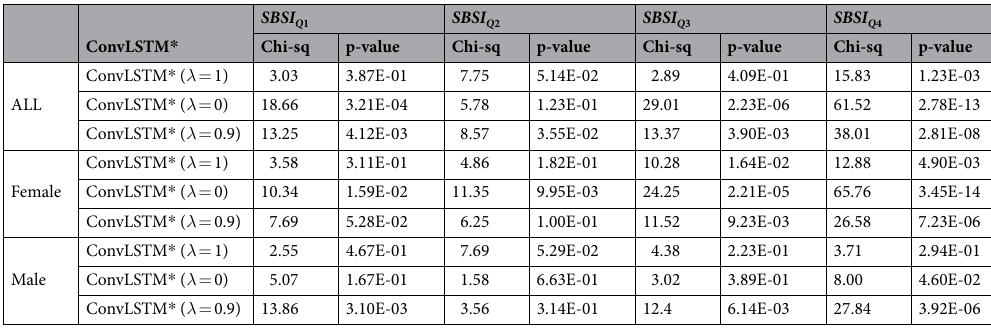
Table 7. Log rank results applying η = − ( ) CA BA for different SBSI categories. Results are shown for model CA with all subjects, female-only, and male-only separately. Q1, Q2, etc. denote 1st quartile, 2nd quartile, etc.